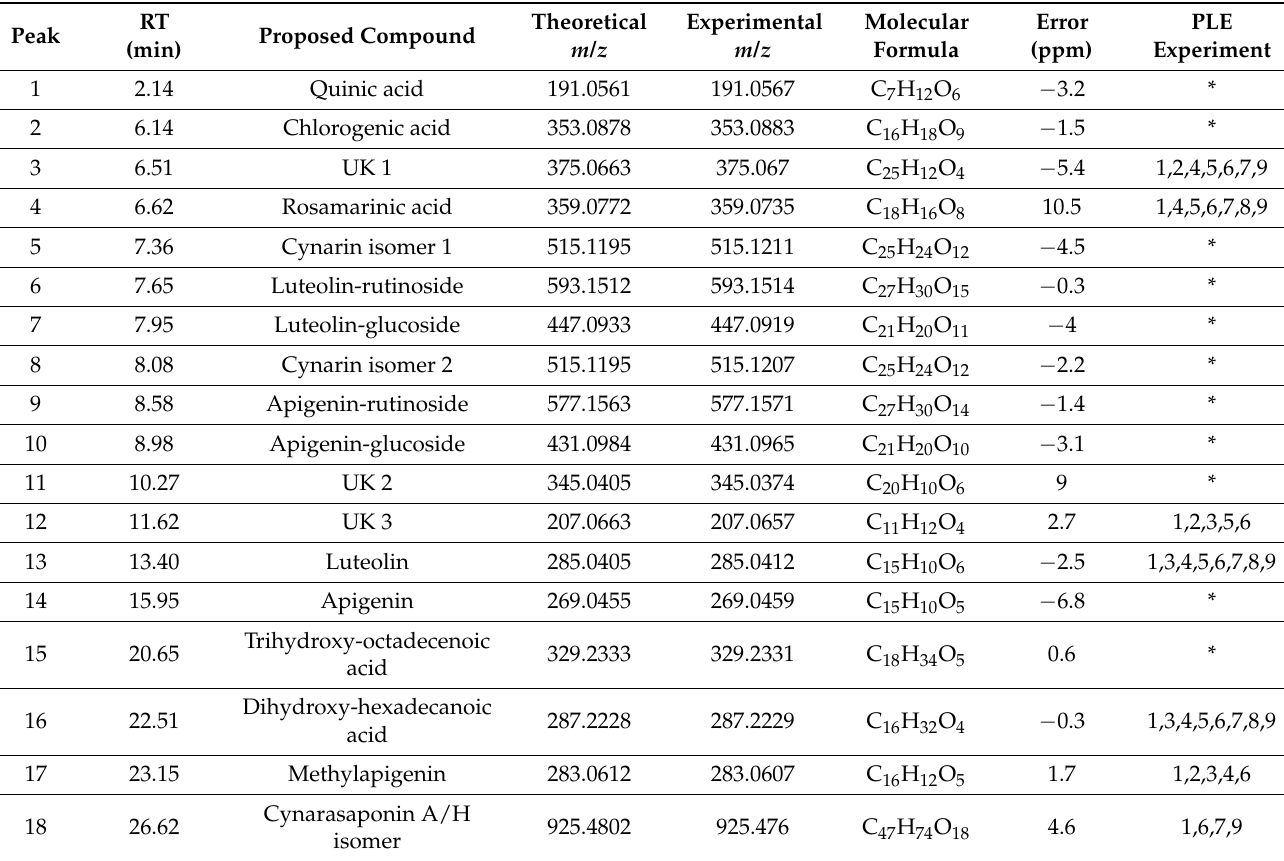
Table 2. Phenolic and other polar compounds characterized in Cynara scolymus L. PLE extracts analyzed by HPLC-time-of- flight mass spectrometry with an electrospray interface (ESI-TOF/MS).